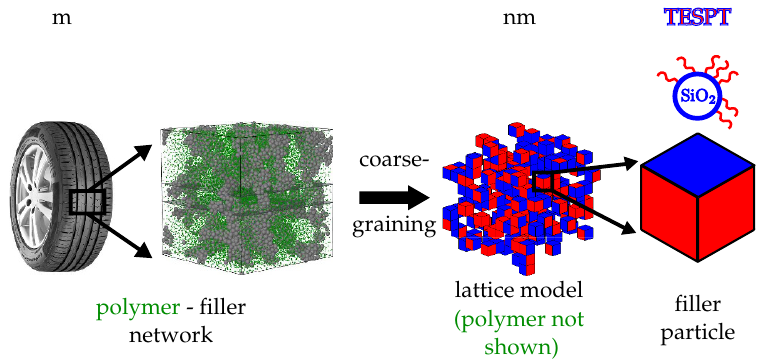
Figure 1. Hierarchy of scales. The polymer matrix within an elastomer composite, here exemplified by a tyre tread material, is reinforced by an embedded filler network. In the current model, the filler particles are approximated by cells on a cubic lattice (coarse graining). The different coloured faces are either representing bare particle surface areas (blue) or silanised areas (red). A specific example are silica particles silanised with TESPT.